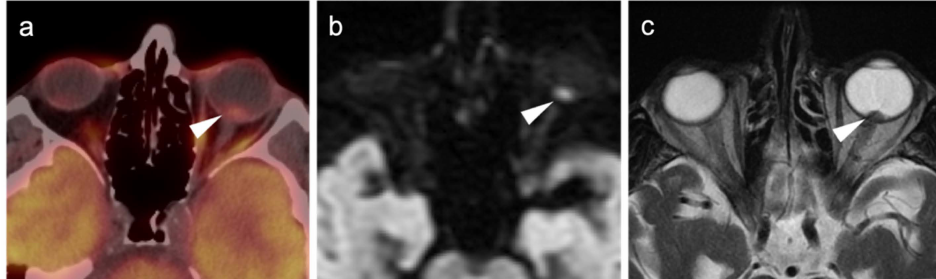
Figure 5. Retinal melanoma. ( a ) Axial FDG PET-CT image of the orbit shows the known left retinal melanoma to be only minimally hypermetabolic (white arrowhead). ( b ) Axial diffusion-weighted imaging (DWI) MRI of the orbit shows the retinal lesion to have high signal (diffusion restriction) (white arrowhead). ( c ) Axial fat-suppressed T2 (T2 FS) MRI image of the orbit shows a retinal nodule corresponding to the melanoma (white arrowhead).